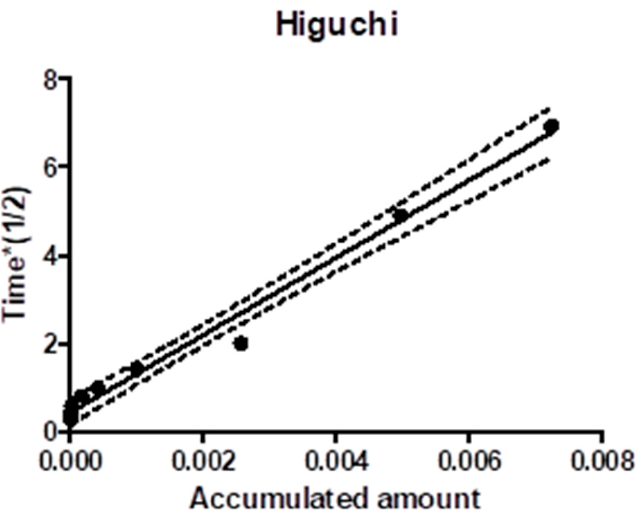
Figure 12. Drug release profiles of the optimized formulation of MA/EA NPs in dialysis tubing bags.